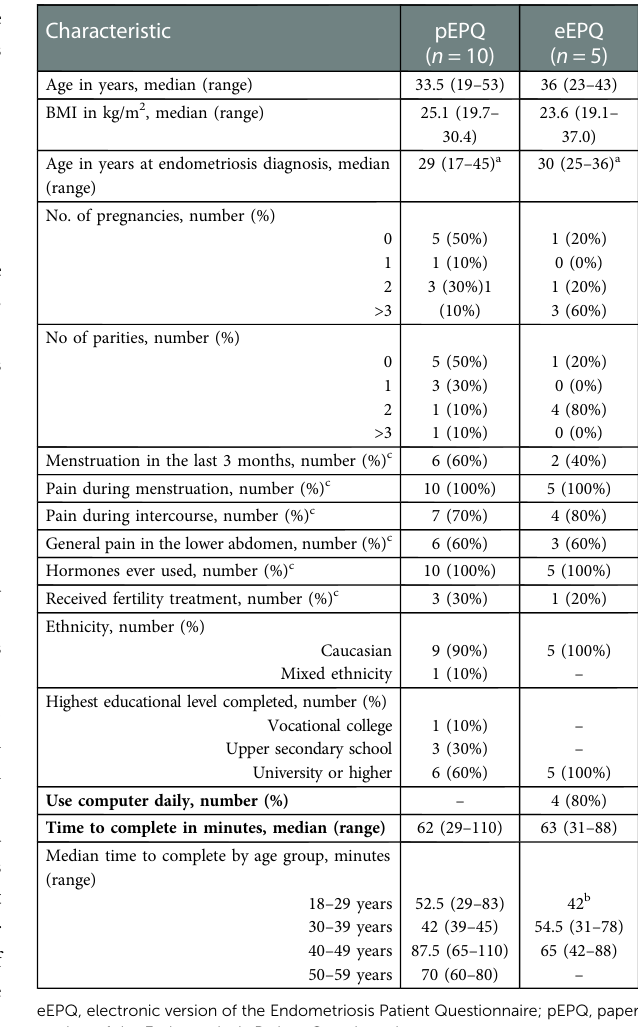
TABLE 1 Baseline characteristics including